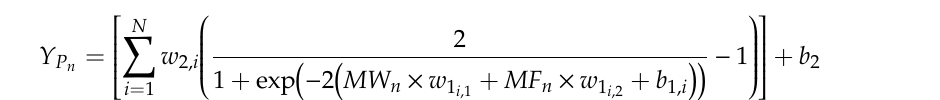
Figure 3. Measured 𝑌 (cid:3017) vs. Predicted 𝑌 (cid:3017) from the ANN model . Figure 3. Measured Y P vs. Predicted Y P from the ANN model.